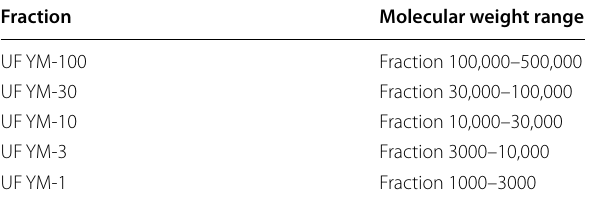
Table 2 The corresponding molecular weight cut-off range of each